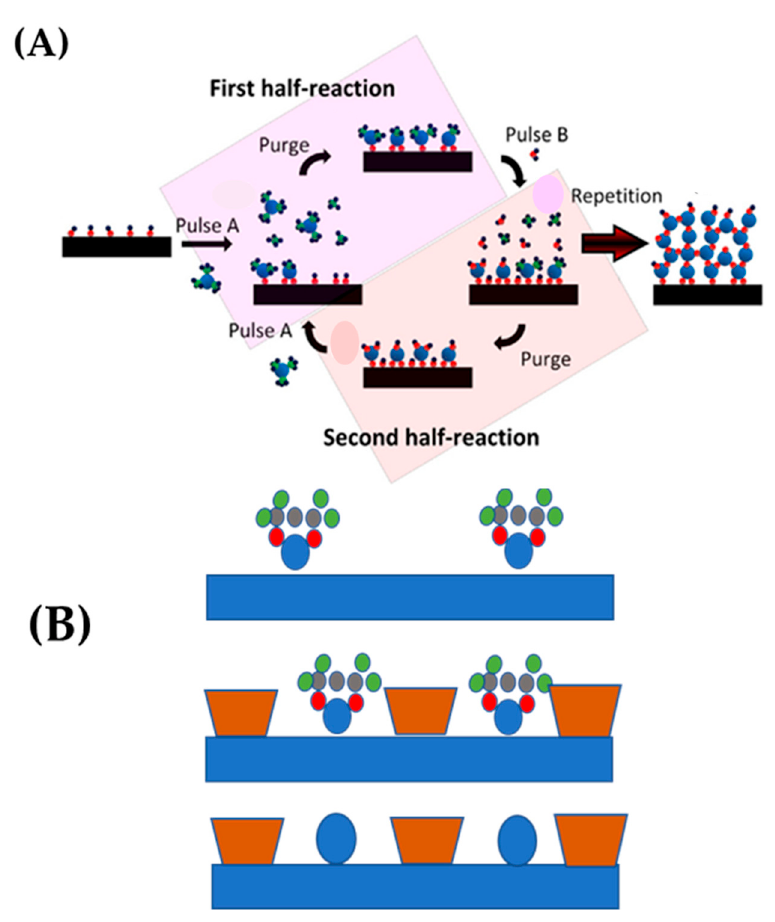
Figure 13. ( A ) Schematic representation of the ALD technique using a binary ( A , B ) precursor system. ( B ) Exposure to a first precursor vapor. Adapted from [57] with permission.